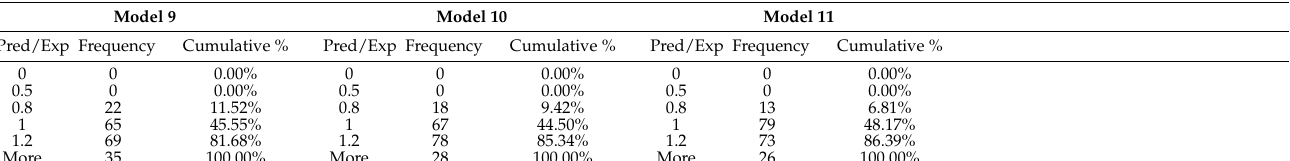
15 of 25 Table 3. Comparison of frequency ratios of predicted to experimental values for the developed models. Model 1